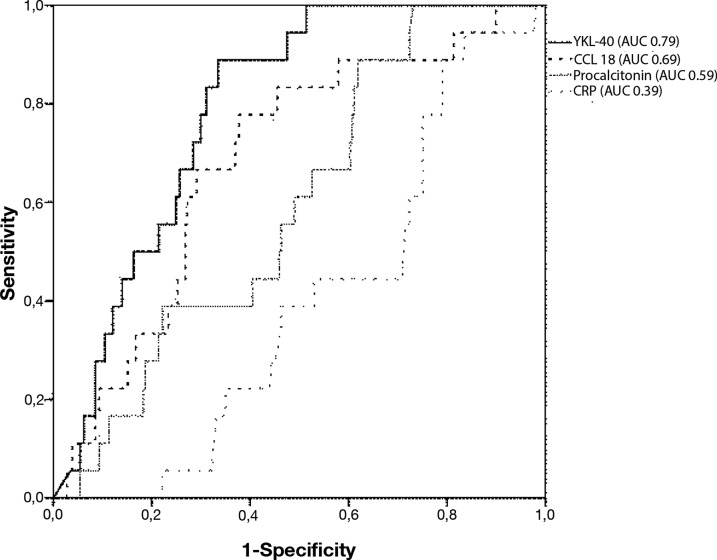
Area under the curve for YKL-40, CCL18, CRP and procalcitonin levels on admission for intracellular aetiology of community-acquired pneumonia.